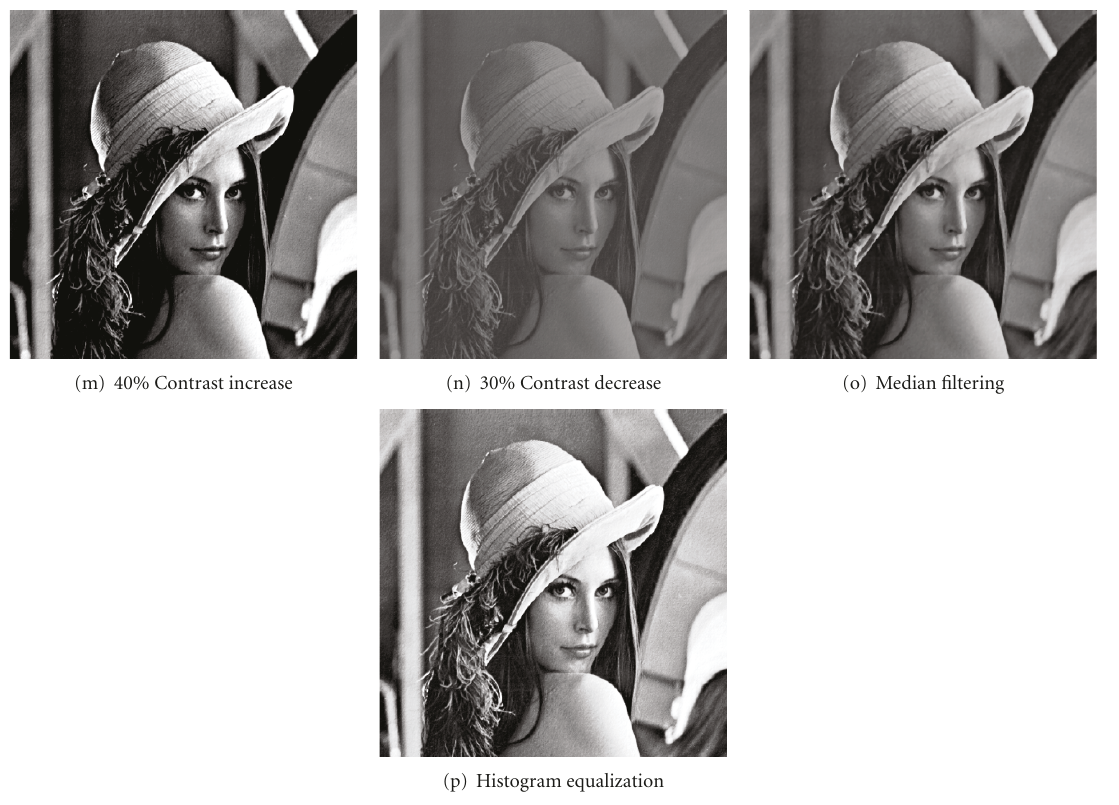
Figure 4: Attacks on the watermarked image Lena.